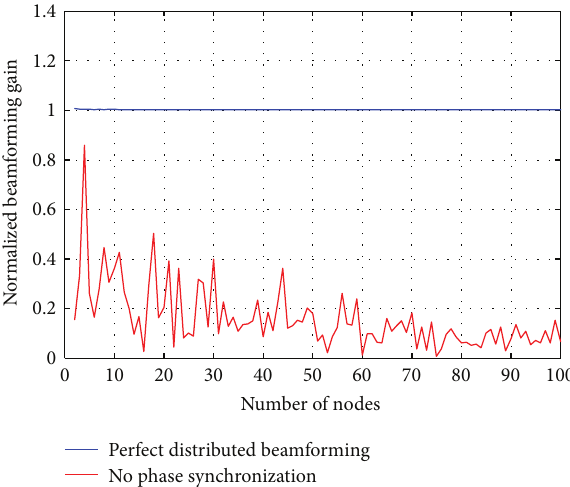
Figure 3: Beamforming gain in case of perfect beamforming and no phase